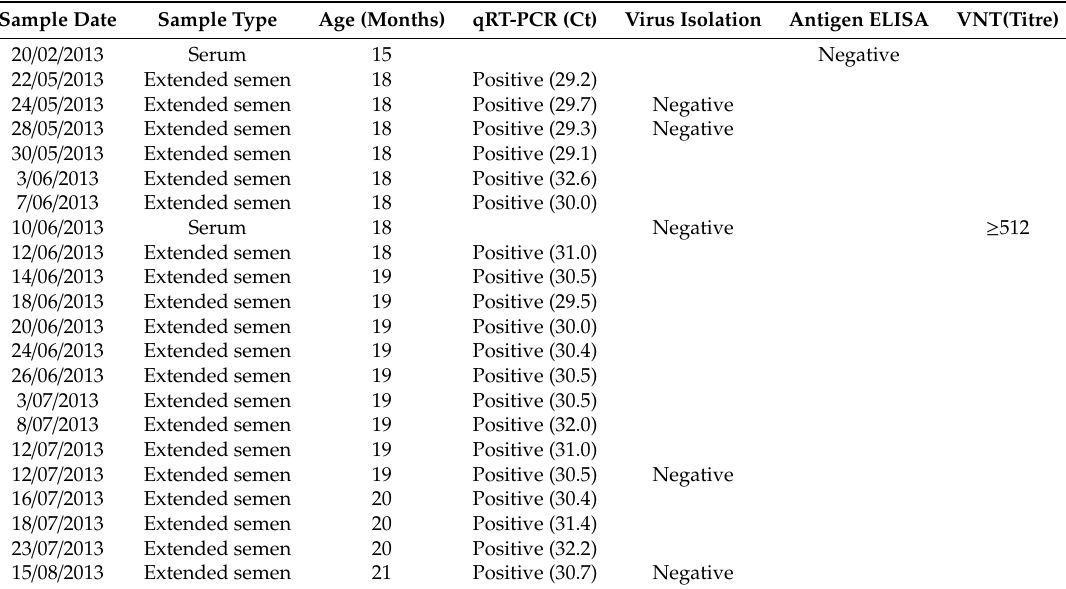
Table A3. Serological and virological test results for Bull 3.